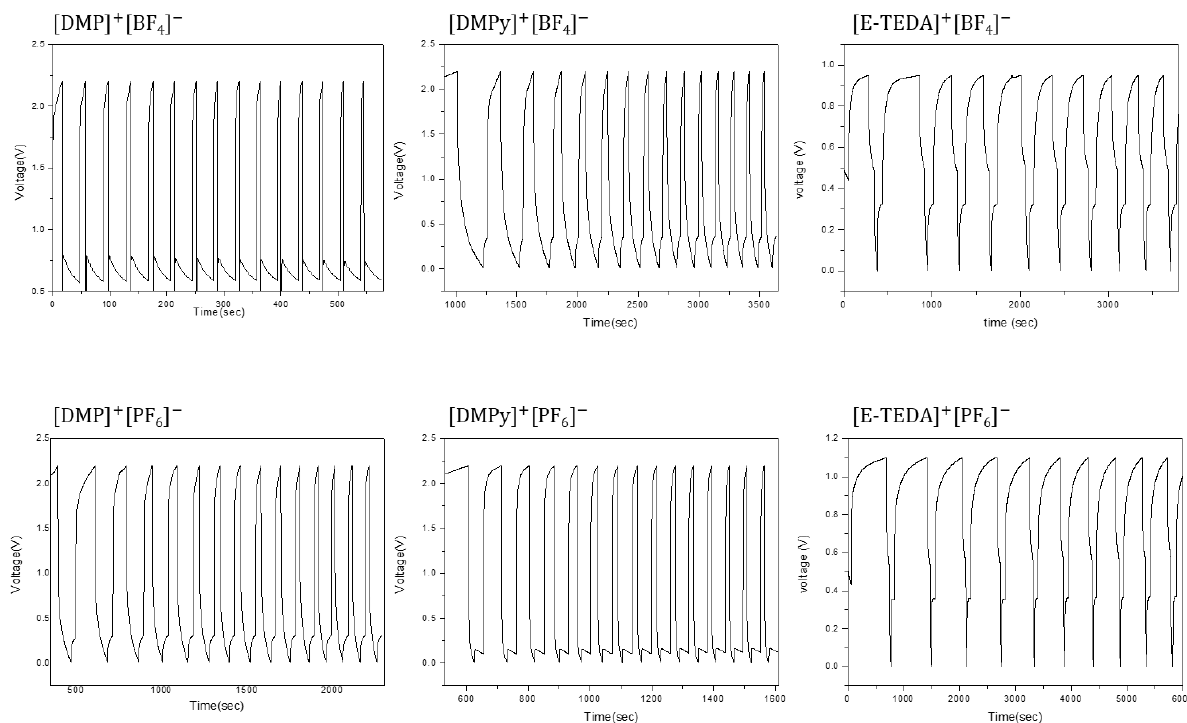
Figure 6. Electrochemical capacitor performance in acetonitrile with 0.01M V(acac) 3 and 0.1 M electrolyte salts (Working condition: set voltage = 2.5 V, I c = 0.1 mA, and I d = − 0.1 mA, Neosepta ® AFN).